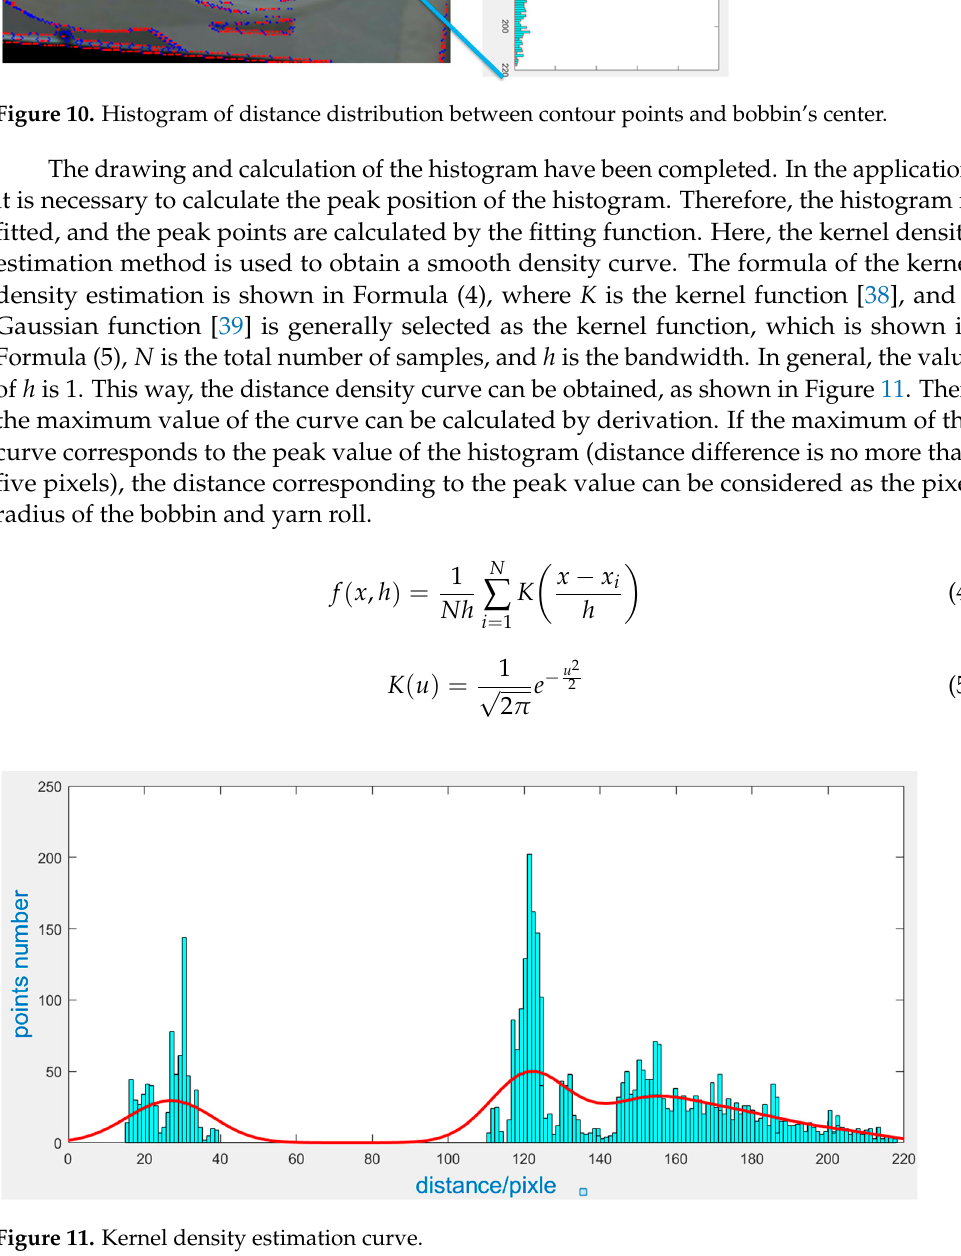
Figure 10. Histogram of distance distribution between contour points and bobbin’s center.